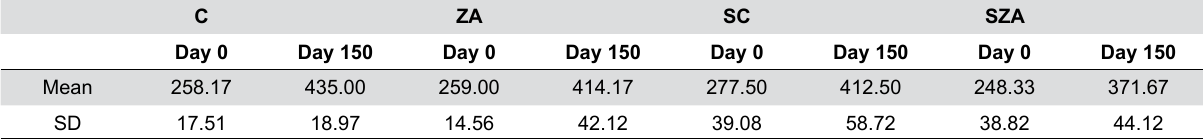
Table 1- Mean values and standard deviations (SD) of the animal weights (g) at day 0 and day 150 for C, ZA, SC and SZA groups